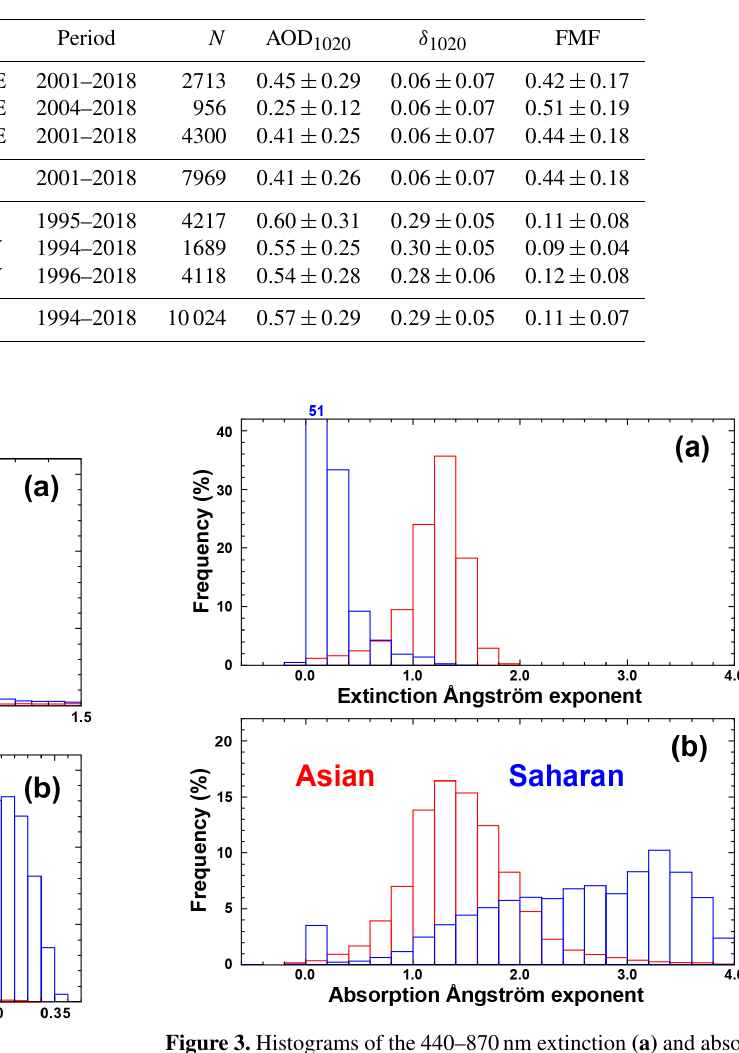
Table 2. Overview of the AERONET sites included in this study in terms of location, length of time series, and number of available version 3 level 2.0 data points. The last three columns refer to mean values and standard deviation of AOD 1020 , δ 1020 , and FMF for the respective sites and regions. The figures in this work refer to the combined Asian and Saharan data sets.